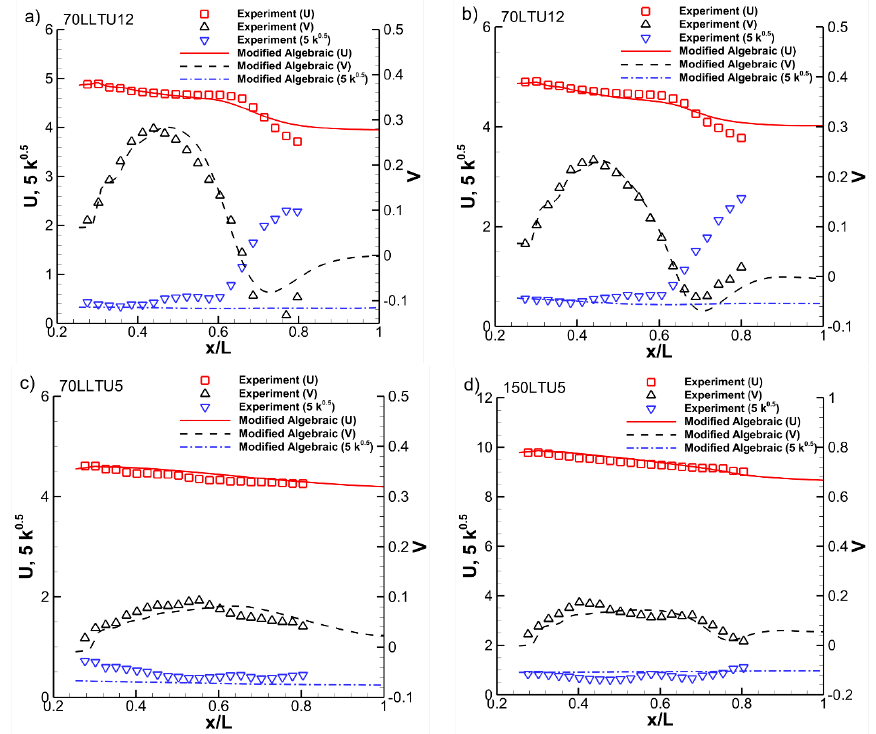
Figure 4. UNIGE flat plate. Mean x- and y- velocity components and turbulent kinetic energy, k, along y/L = 0.04. Transition in the separated boundary layer ( a , b ), laminar boundary layer prone to separation ( c ) and bypass transition ( d ). Symbols denote the PIV results.